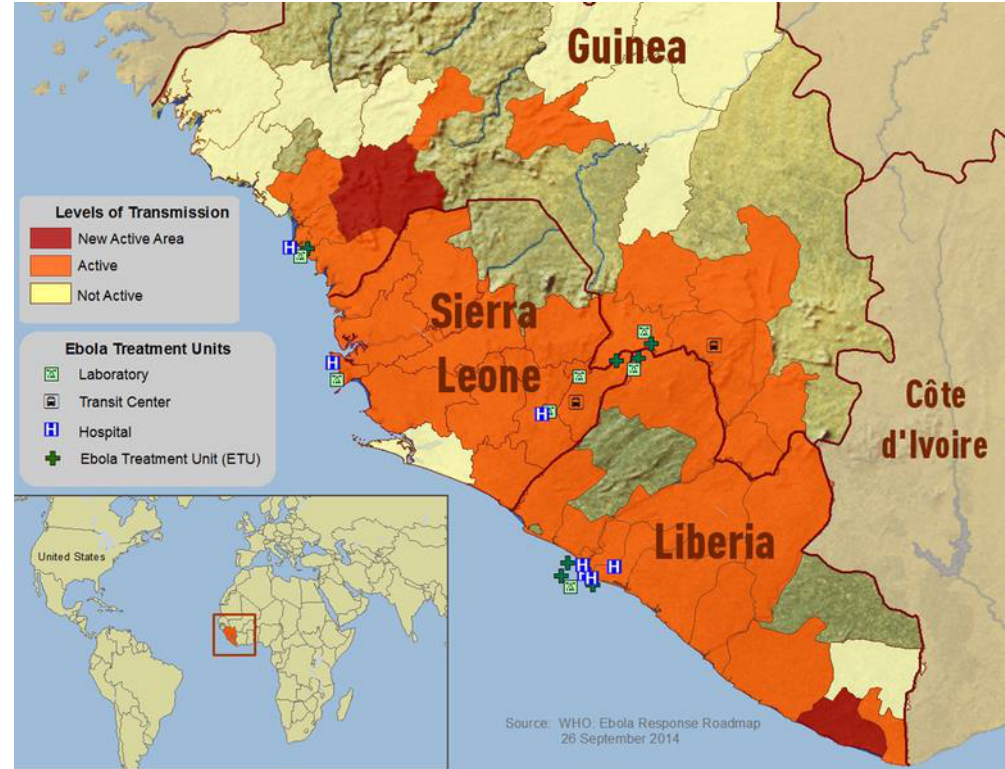
Figure 1. WHO Ebola 2014 outbreak map of Guinea, Liberia, and Sierra Leone. Source: Retreived from https://commons.wikimedia.org/wiki/File:Ebola_2014_outbreak_map_of_Guinea,_Liberia,_and_Sierra_Leone.png (accessed on 10 March 2021 ).